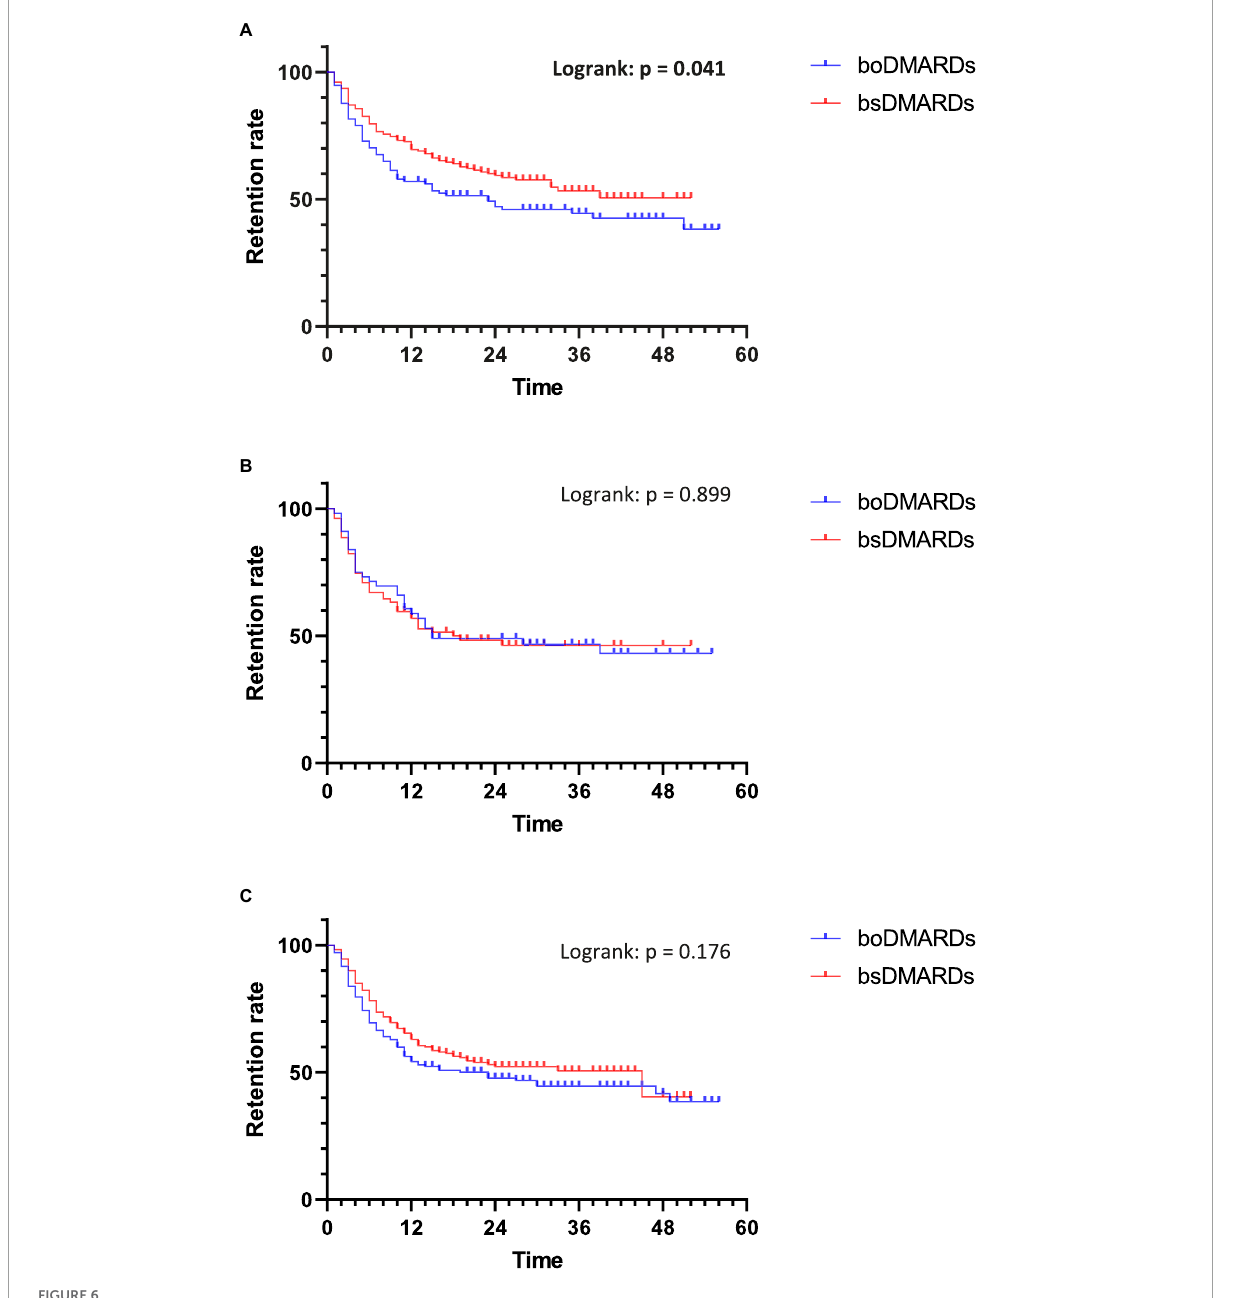
FIGURE6 Retention of treatments in each rheumatic disease. (A) Rheumatoid arthritis; (B) Psoriatic arthritis; (C)